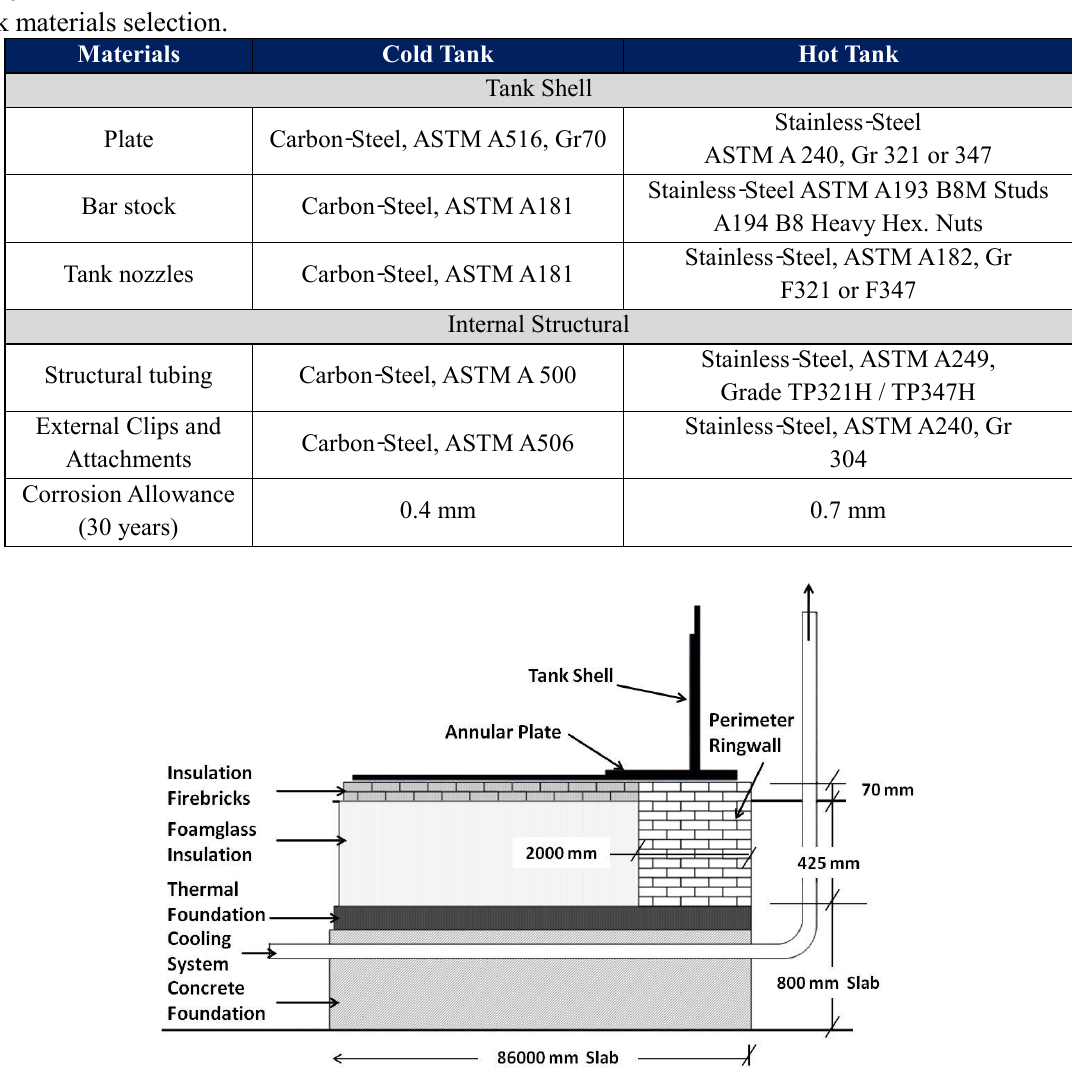
Fig. 2. The foundation